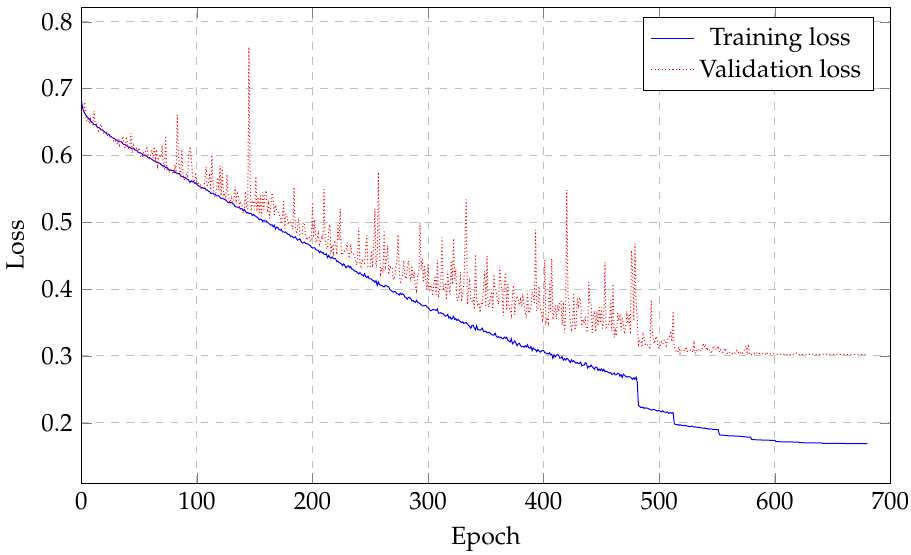
Figure 7. The 10-layer DNN training and validation loss. It shows that the network has stopped learning 500 epoch in which the validation is not degraded. The model presented a training AUC of 98.44% and testing AUC of 94.53% as can be seen in the ROC curves in Figure 8.